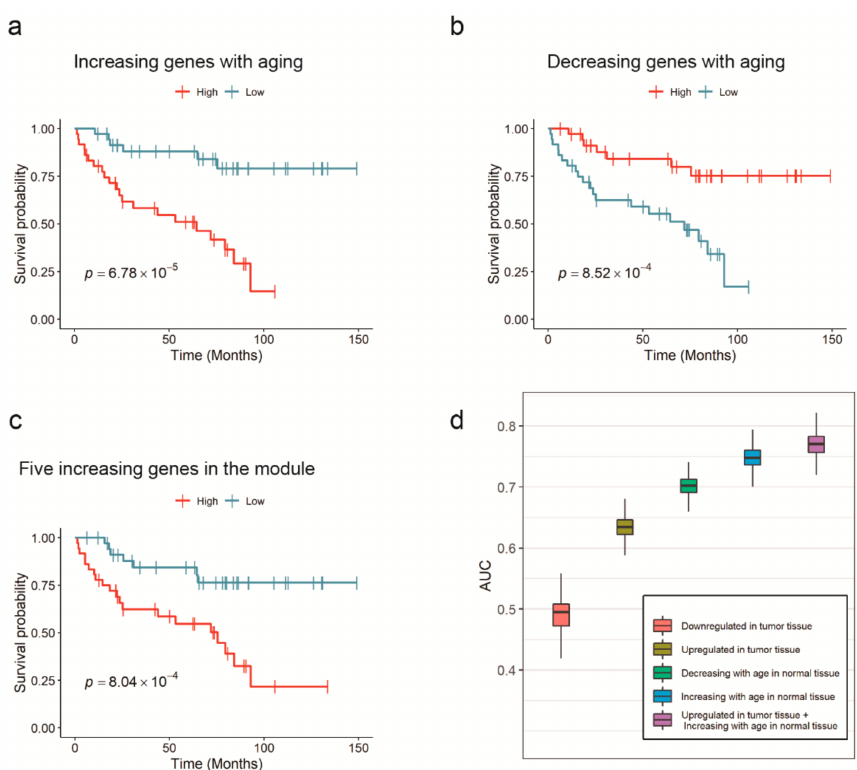
Figure 2. Survival analysis and prognostic capability of aging-related genes in KIRC. ( a – d ) Kaplan– Meier overall survival curve of aging-related genes or miRNAs. The patients were grouped by the average expression of: ( a ) increasing genes and ( b ) decreasing genes in TCGA-KIRC. ( c ) The average expression value of five upregulated genes in the module ( DUSP22 , MAPK14 , MAPKAPK3 , STAT1 , and VCP ) also had a predictive power. ( d ) AUCs from survival prediction models with five different input variables were compared. Expression levels of aging-related genes in normal kidney tissue exhibited better survival prediction performance than DEGs in KIRC tissue. The best performance was achieved when both aging-related genes and DEGs were simultaneously